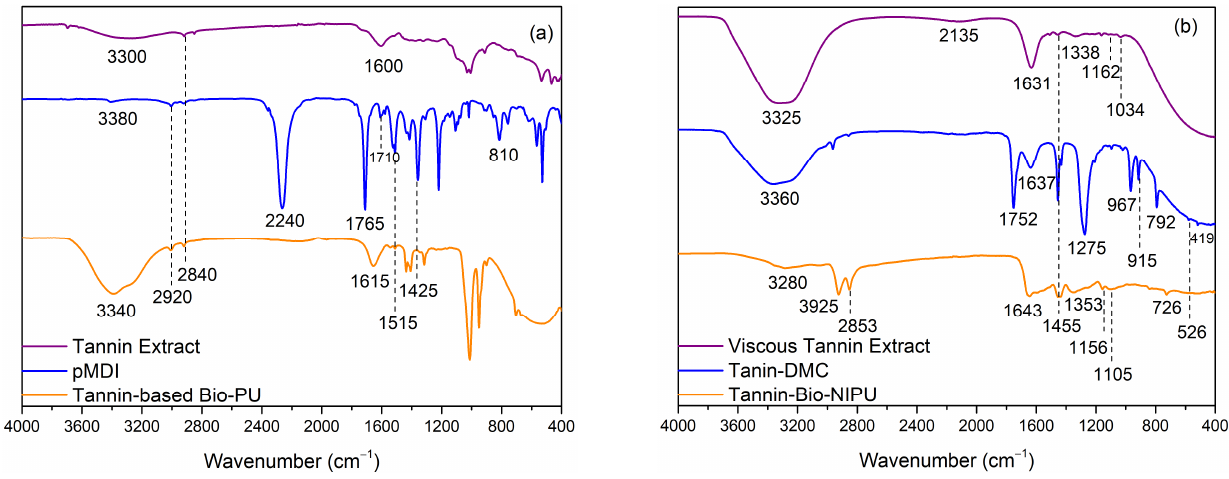
Figure 2. Spectra FTIR of tannin-based Bio-PU ( a ); tannin-based Bio-NIPU ( b ). Figure 2b provides a typical spectrum of the tannin-based Bio-NIPU synthesis